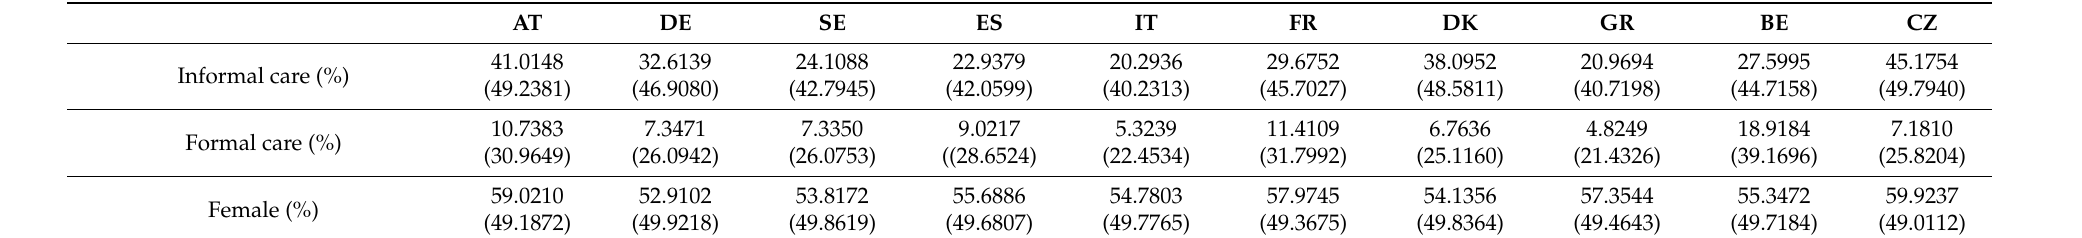
Table 2. Summary of statistics by